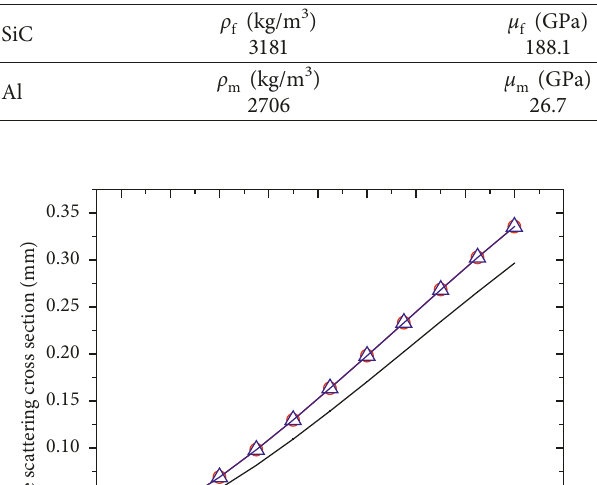
Table 1: Material properties of SiC and Al.